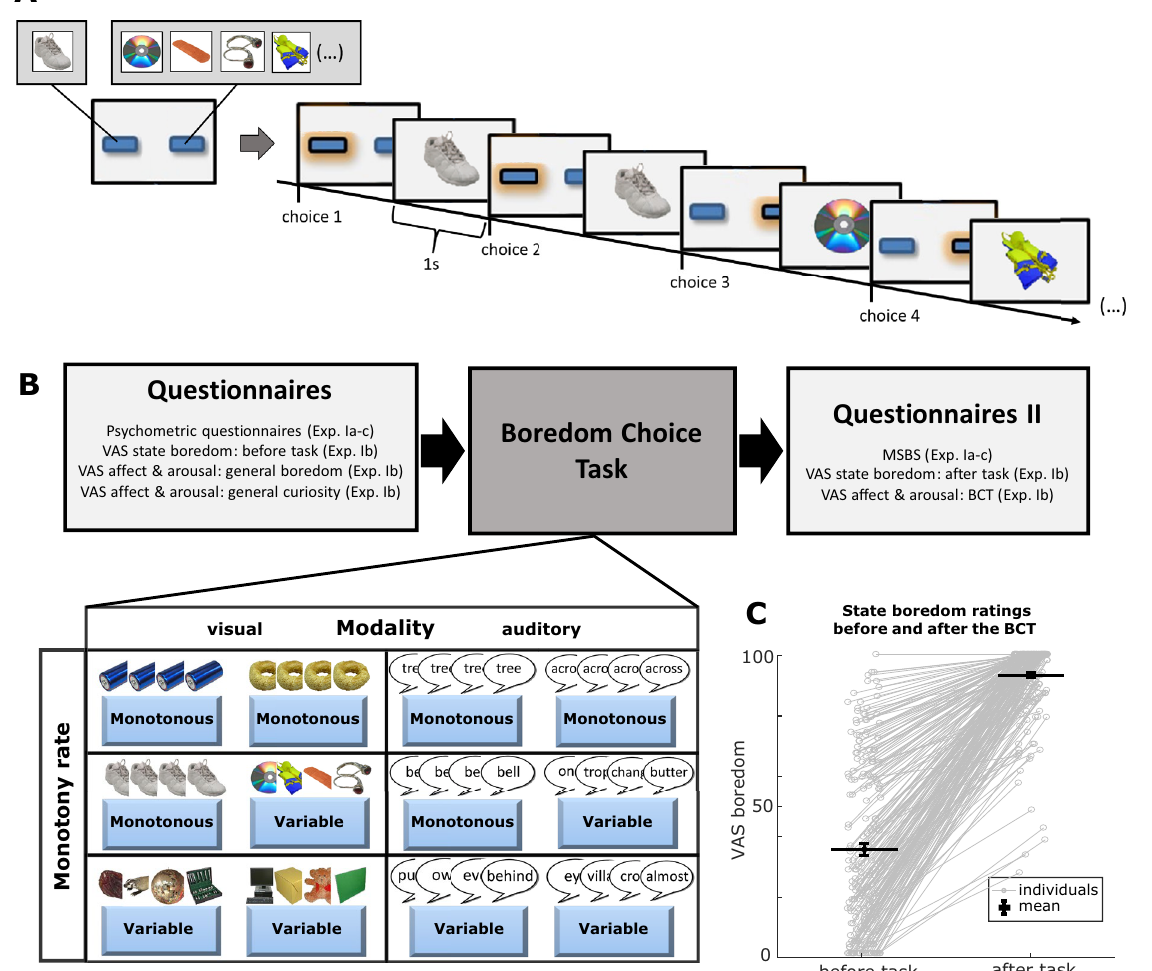
Figure 1. Concept of the Boredom Choice Task : ( A ) Trial structure of the paradigm and example sequence of choices and stimulus presentations in the monotonous vs. variable condition, where the monotonous alternative in this example is located left. The shaded buttons represent the currently chosen options. ( B ) Schematic of the procedure, illustrating six basic task conditions ( monotonous vs. variable, monotonous vs. monotonous, variable vs. variable in visual and auditory modality). Images are examples from the visual stimulus libraries taken from the Bank of Standardized Stimuli 59,60 . The structure of the experiments involved the BCT and various self-report questionnaires to assess boredom (BPS, MSBS, VAS-B), personality traits and symptoms of mental disorders (GHQ-28, CAARS-S:L, BDI-II, BFI-10, I-8, STAI-Y, BRS) as well as affect and arousal for imagined states of boredom, curiosity and the BCT (VAS-AA). ( C ) Visual analog state boredom ratings (VAS-B) before starting and after completing the Boredom Choice Task. Connected grey circles reflect the ratings of each individual (n = 201 participants). The horizontal bars reflect the average over all subjects and the vertical bars indicate the standard error of the mean. The boredom ratings after the task are significantly higher compared to the prior condition (p < 0.001 in a Wilcoxon signed rank